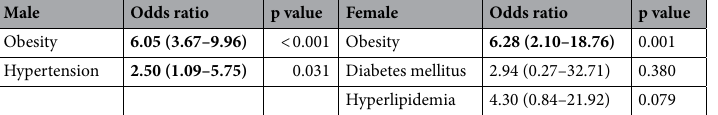
Table 4. Independent factors associated with OSA among young adults. Significant values are given in